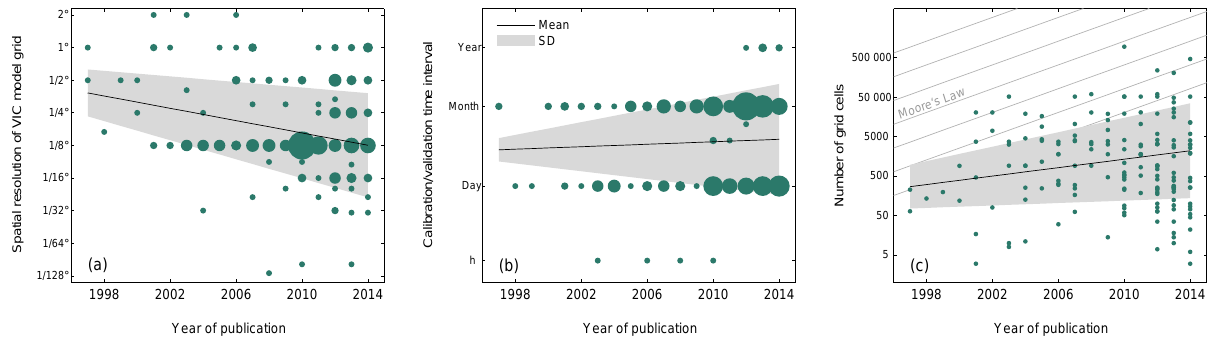
Figure 3. The year of publication versus the highest spatial resolution of the VIC model that was used in the study (a) , the smallest time interval on which the calibration and/or validation of the VIC model was performed (b) , and the total number of grid cells in the study (c) based on 192 peer-reviewed studies. The grey lines in (c) show the slope of computational power increase according to Moore’s law (Moore, 1965). The point size is proportional to the number of studies that were published in a certain year with a certain spatial or temporal resolution. If the spatial resolution was given in kilometres, it was assumed that 1 ◦ = 100km. For the total number of grid cells, catchment size was divided by cell size, assuming that 1 ◦ = 100km, unless the number of grid cells was explicitly given. Statistics (the mean and the standard deviation) have been obtained per year on logarithmically transformed data. With linear regression a line was fitted through the mean and the standard